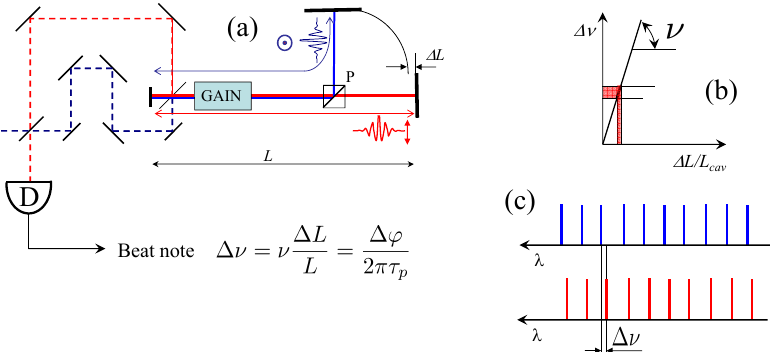
Figure 2. Active interferometry. ( a ) the 2 pulse/cavity mode-locked laser. The two pulses are orthogonally polarized, and split into two branches in a Michelson-like end-cavity interferometer. The two pulses extracted from the cavity are made to interfere via a beating interferometer. The frequency of the beat signal is a measure of the elongation ∆ L . ( b ) The slope of the response ∆ ν ( ν ) is the optical frequency ν . ( c ) The detector D records the interference of two frequency combs, with a 100%